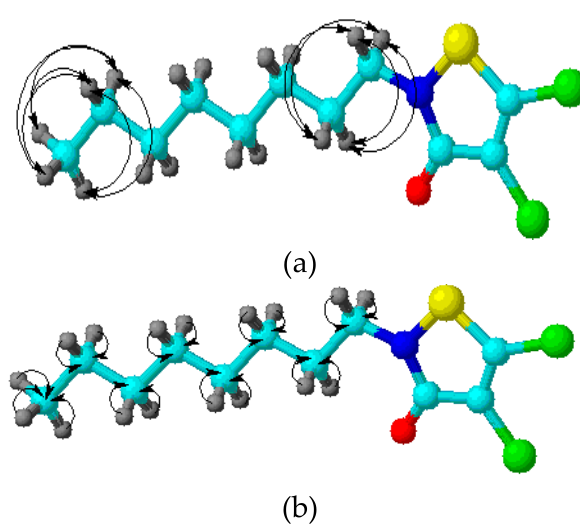
Figure 9. Correlation diagram in the COSY ( a ) and HMQC spectra ( b ).